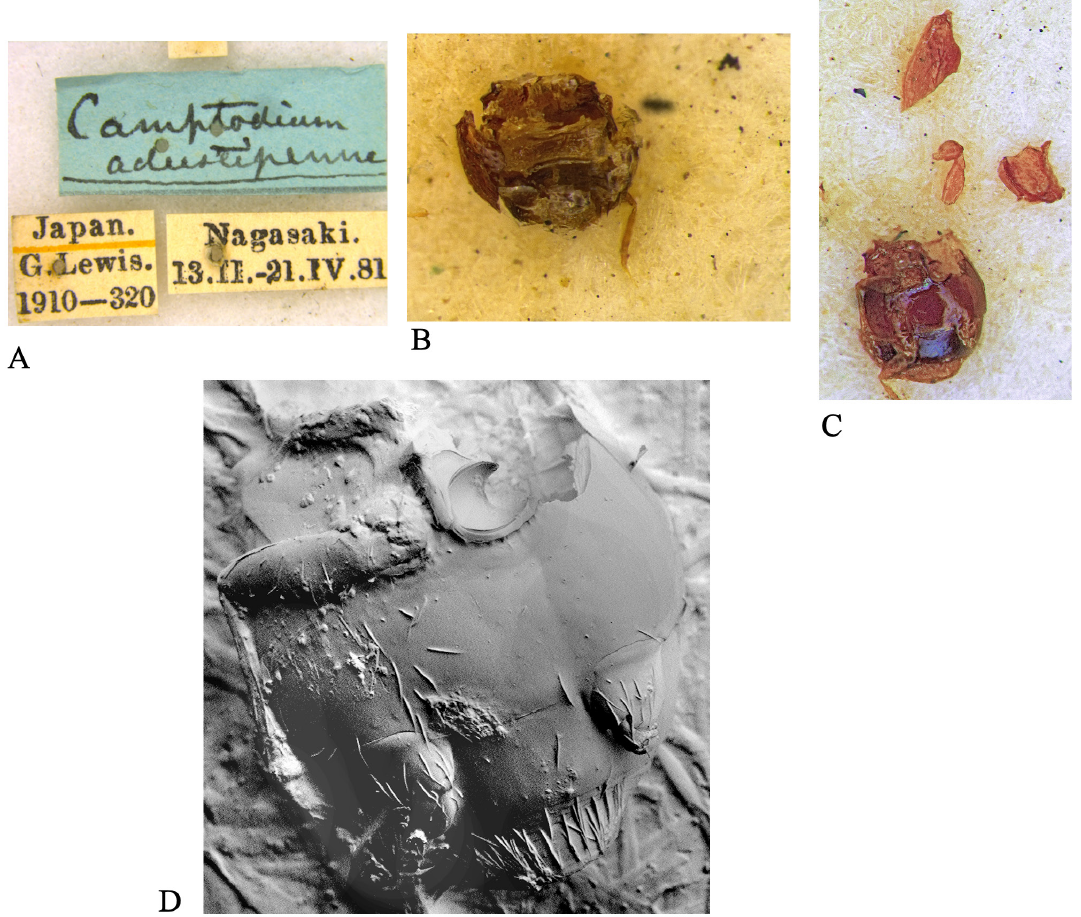
Fig. 8. Cissidium adustipenne (Motschulsky, 1869). A . Labels. B . Specimen as found. C–D . Specimen after